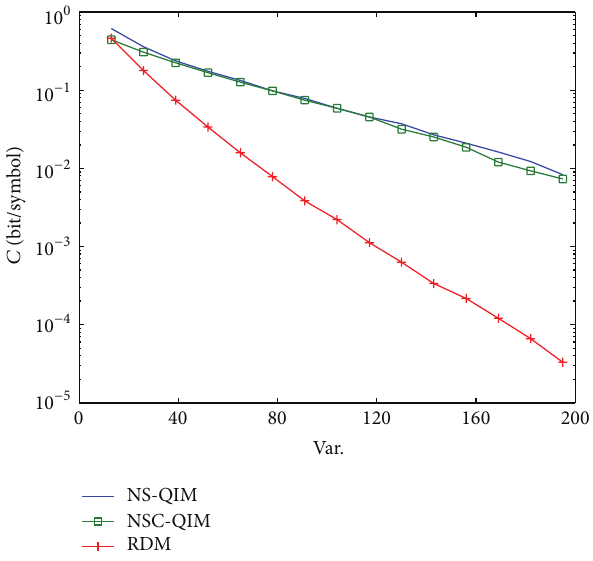
Figure 7: Capacity under GA followed by AWGN.